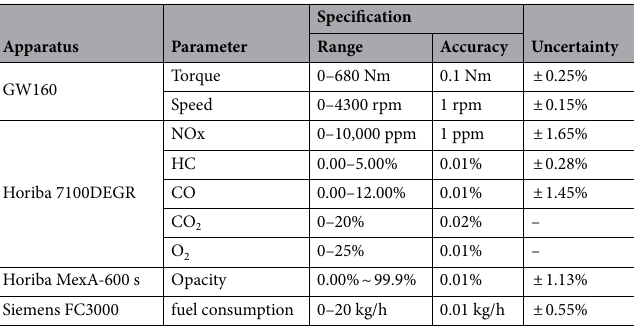
Table 2. Specifications of the testing